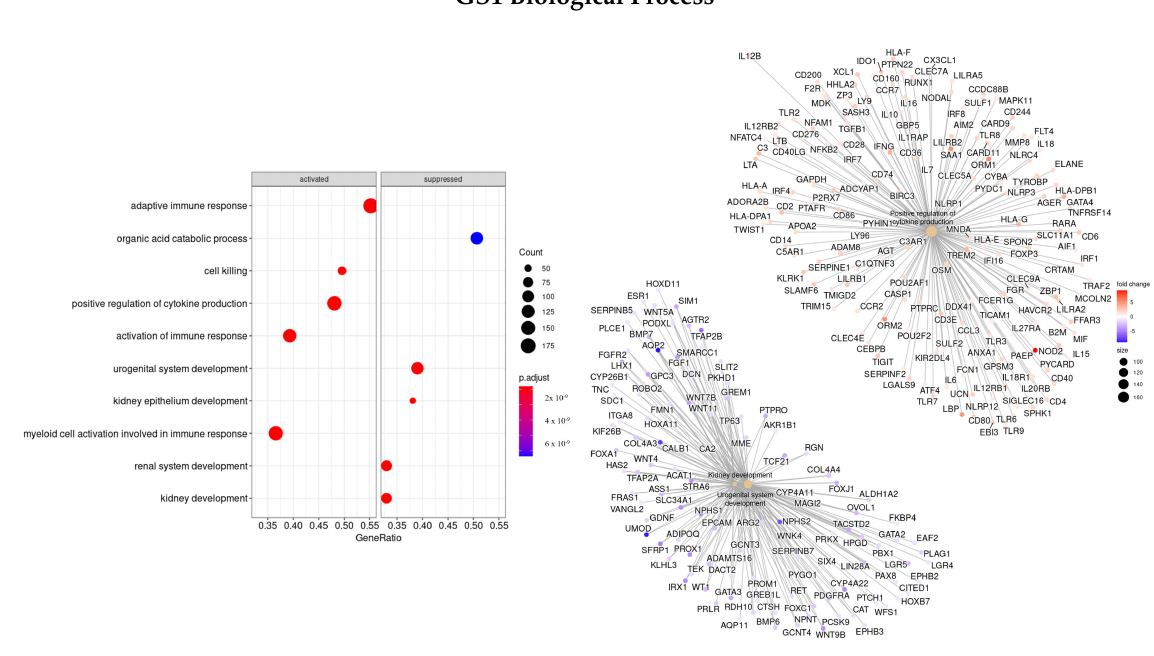
Figure 1. Gene ontology enrichment analysis regarding biological processes terms for a list of DEGs ranked by the log fold change between tumor and normal tissues. The left panel shows a dot chart with the most significant BP terms. The right panel shows a gene-concept network plot of the three most enriched terms that depicts the linkages of genes and biological concepts as a network.